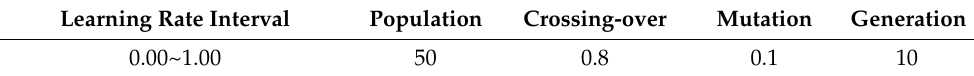
Figure 8. Efficiency predicted value by BP without learning rate optimization ( η = 0.01).